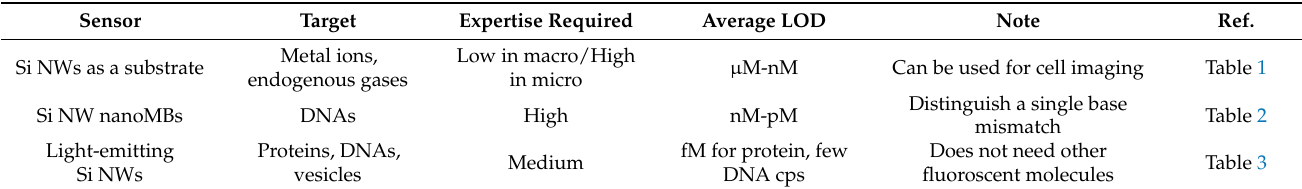
Table 4. Comparison between different fluorescent Si NW